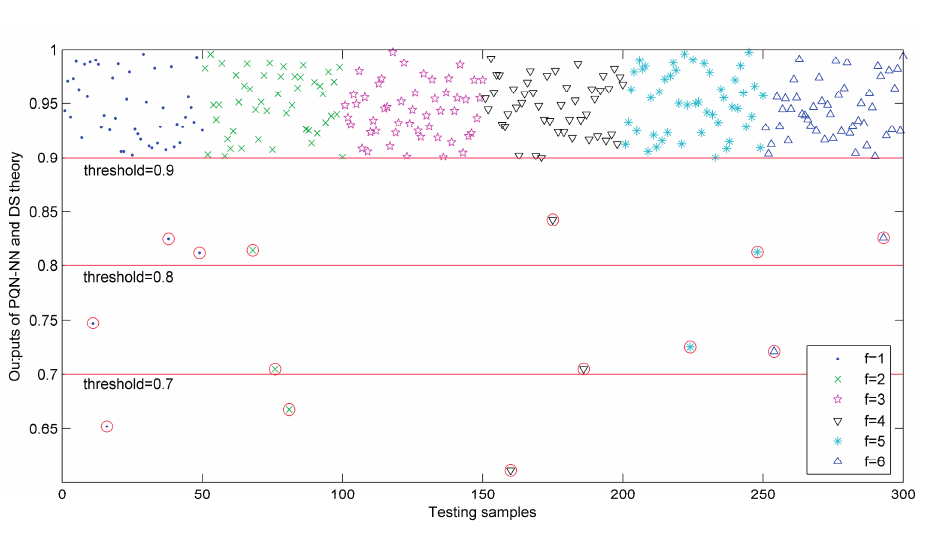
Figure 8. Output results based on PQN-NN and DS theory for 300 testing